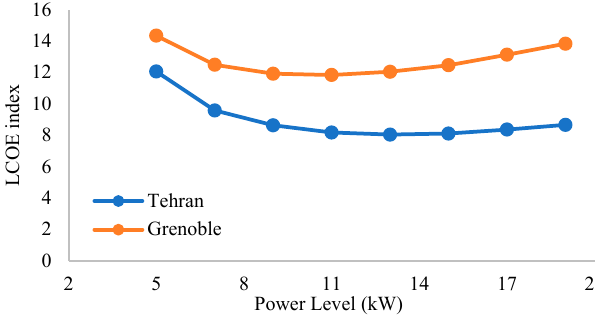
Figure 20. LCOE index comparison for Grenoble and Tehran.